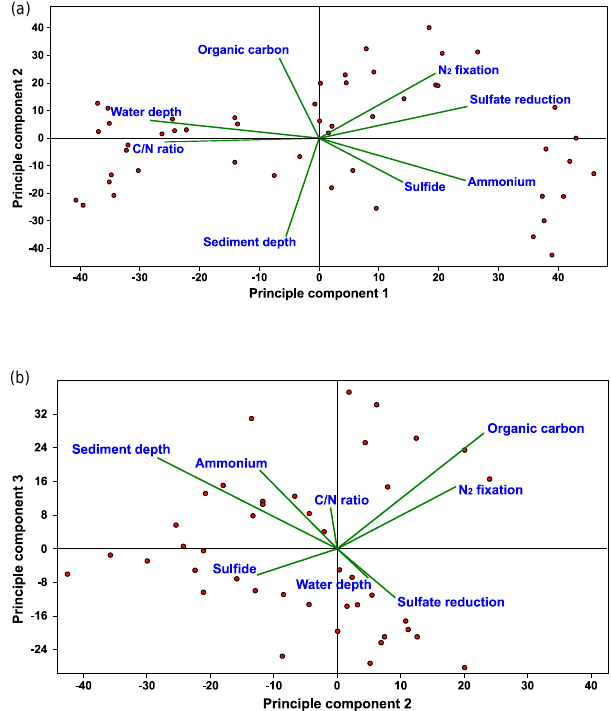
Figure 6. Principle component analysis (PCA) from two different angles of Hellinger transformed data of N 2 fixation and environ- mental parameters along vertical profiles. Correlation biplots (a) of principle components 1 and 2 and of (b) principle components 2 and 3 in a multidimensional space are shown. Samples are displayed as dots while variables are displayed as lines. Parameters pointing into the same direction are positively related; parameters pointing in the opposite direction are negatively